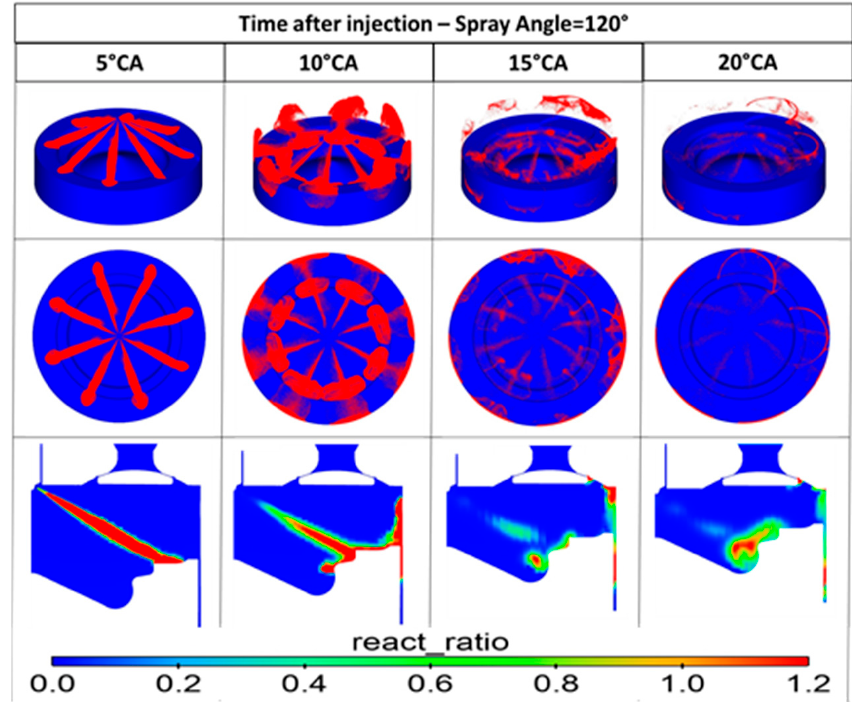
Figure 31. For an SIA of 120°, spray penetration in oblique side and top views and RER contour plot in a planar section through the cylinder axis and a spray axis.